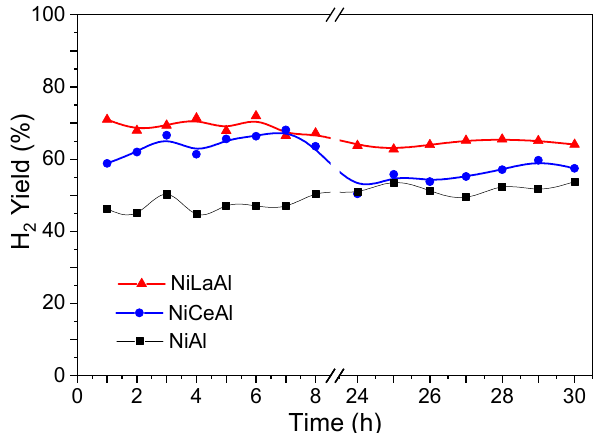
Figure 6. Hydrogen yield versus time on stream.